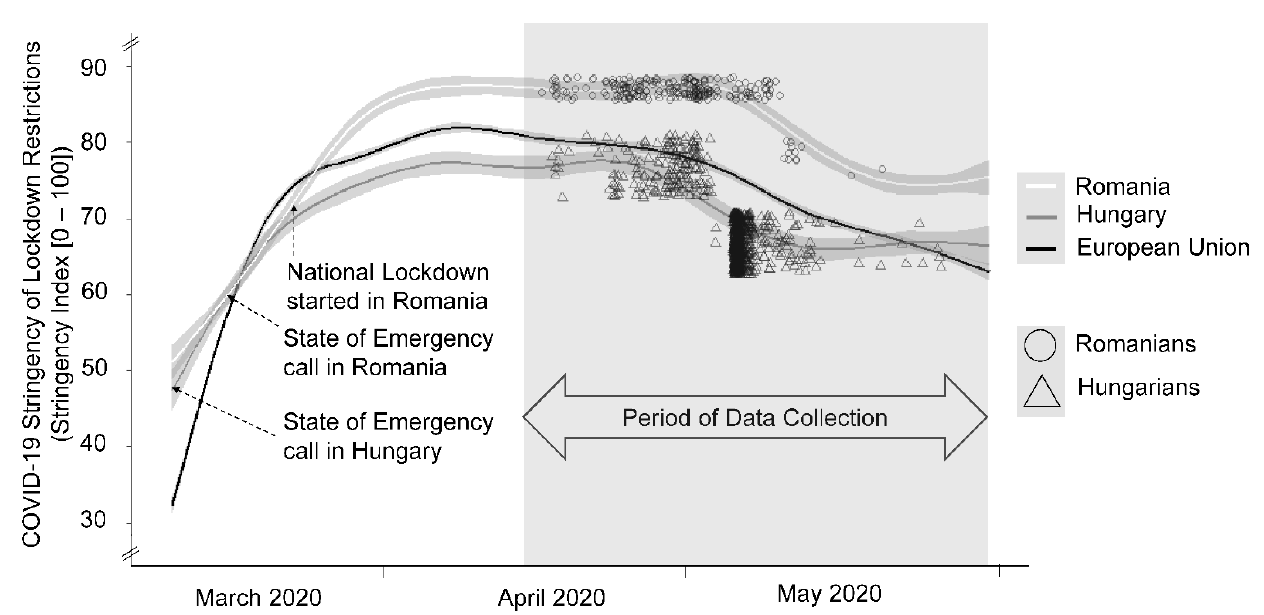
Figure 1. Description of the governmental stringency of lockdown conditions during the first months of the COVID-19 pandemic in Hungary and Romania. The dots and triangles represent the distribution of each individual’s SI score (not the P SIW ), referring to the day of participation in the present study, and show that all participants had experienced more or less country-specific governmental restrictions for at least one month before participation.